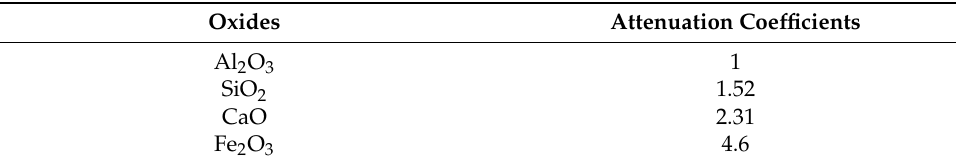
Table 4. Attenuation coefficients of metal oxides.